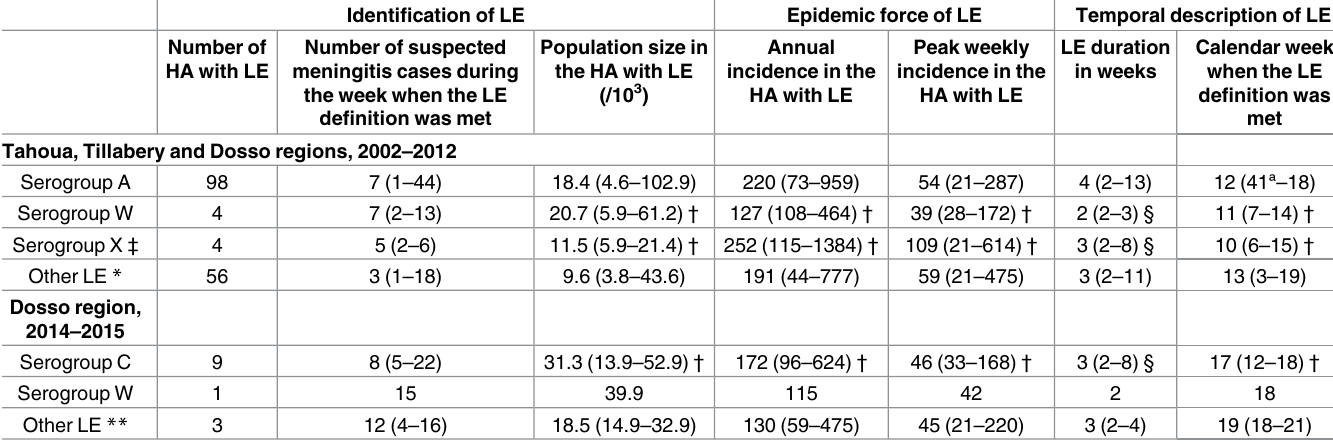
Table 1. Characteristics of meningitis localized epidemics at the health area level in Niger, by epidemic agent. Tahoua, Tillabery and Dosso regions, 2002–2012and Dosso region, July